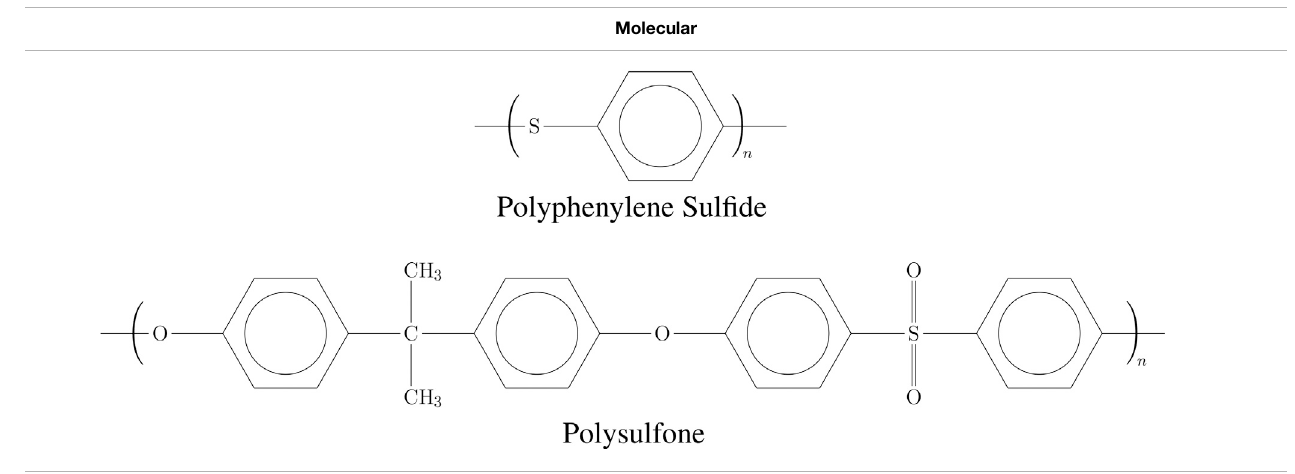
TABLE 1 | Molecular formula of PPS-40%gf and PSU.